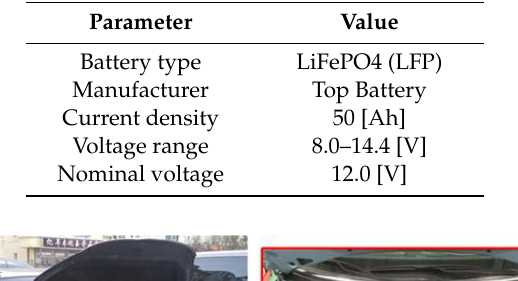
Figure 14. Setup for cranking experiments.